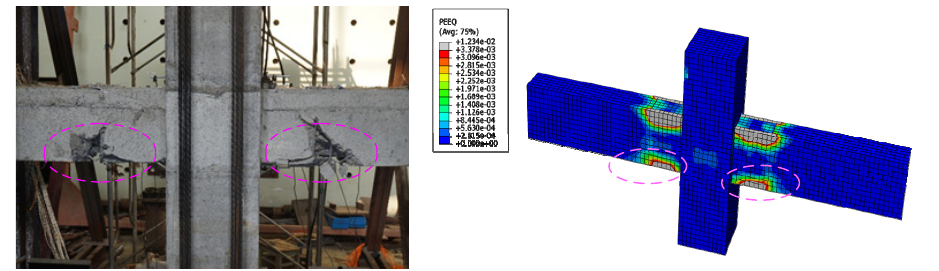
Figure 20. The failure morphology.